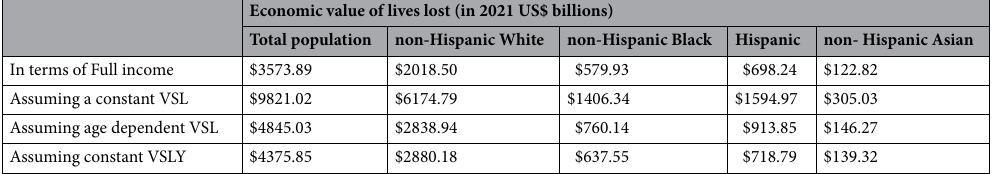
Table 2. The economic value of lives lost due to COVID-19 in the United States from January 1, 2020, to May 7, 2022, by race and ethnic origin. Estimated in terms of full-income, assuming a constant value of a statistical life (VSL), an age-dependent VSL value and a constant value of a statistical life year